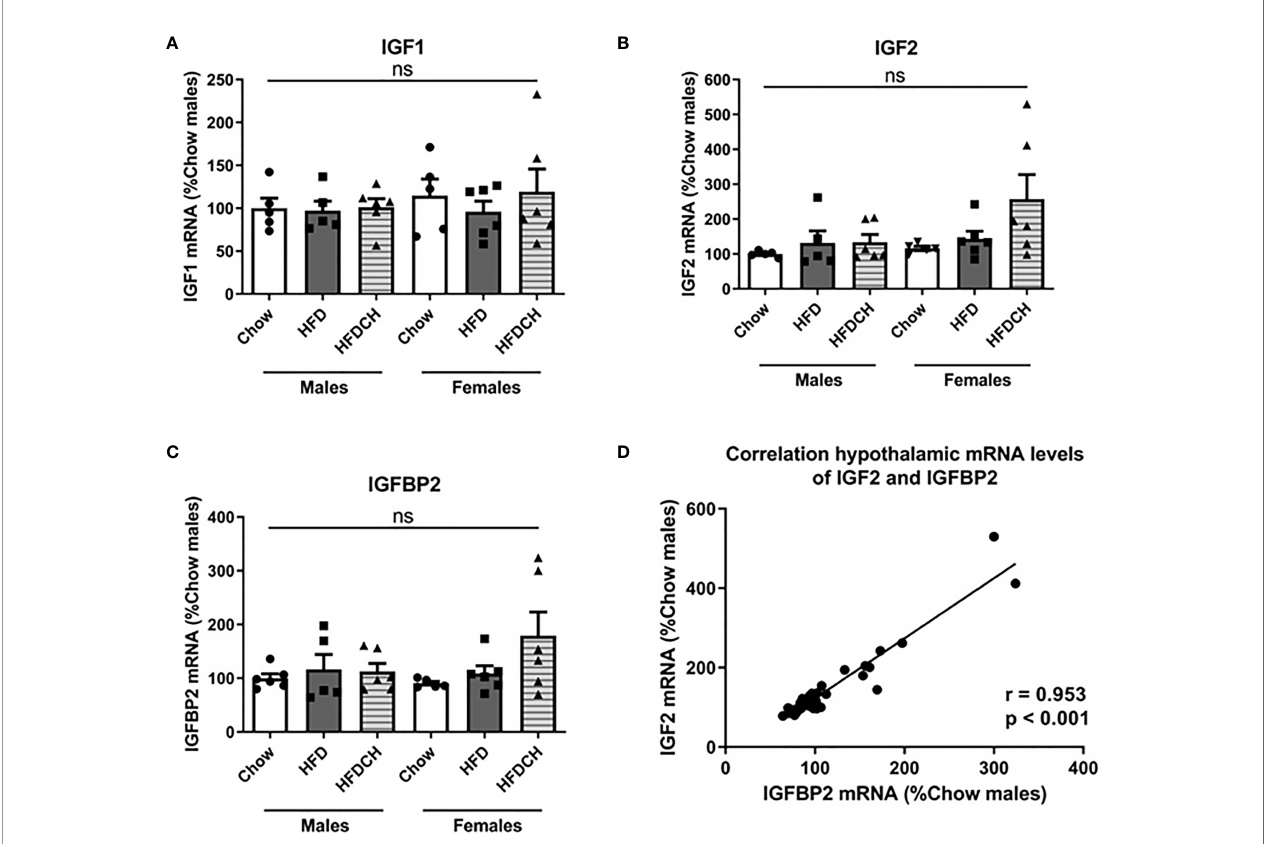
FIGURE 6 | Relative mRNA levels of insulin-like growth factor (IGF)1 (A) , IGF2 (B) and IGF binding protein (IGFBP)2 (C) in the hypothalamus, as well as the correlation of hypothalamic IGF2 and IGFBP2 mRNA levels (D) . HFD = high-fat diet (HFD); HFDCH = 8 weeks of HFD followed by 4 weeks of chow. ns, non- signi fi cant. n =